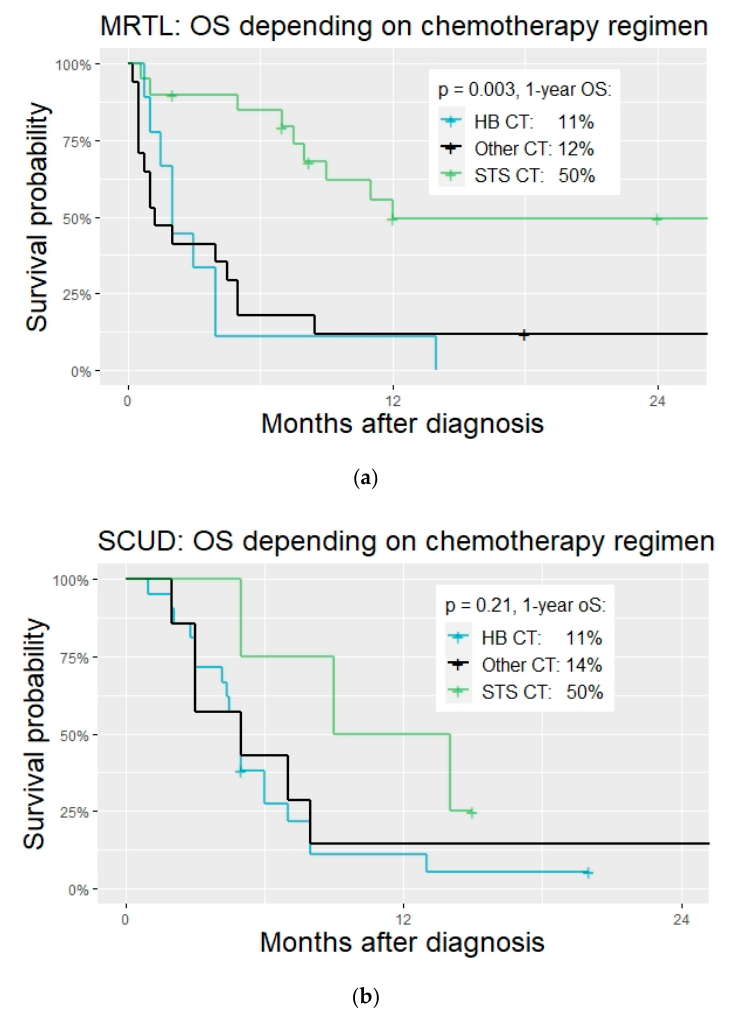
Figure 5. OS of patients with MRTL and SCUD according to different applied CT regimens. ( a ) OS of patients with MRTL and different CT regimens ( b ) OS of patients with SCUD and different CT regimens.